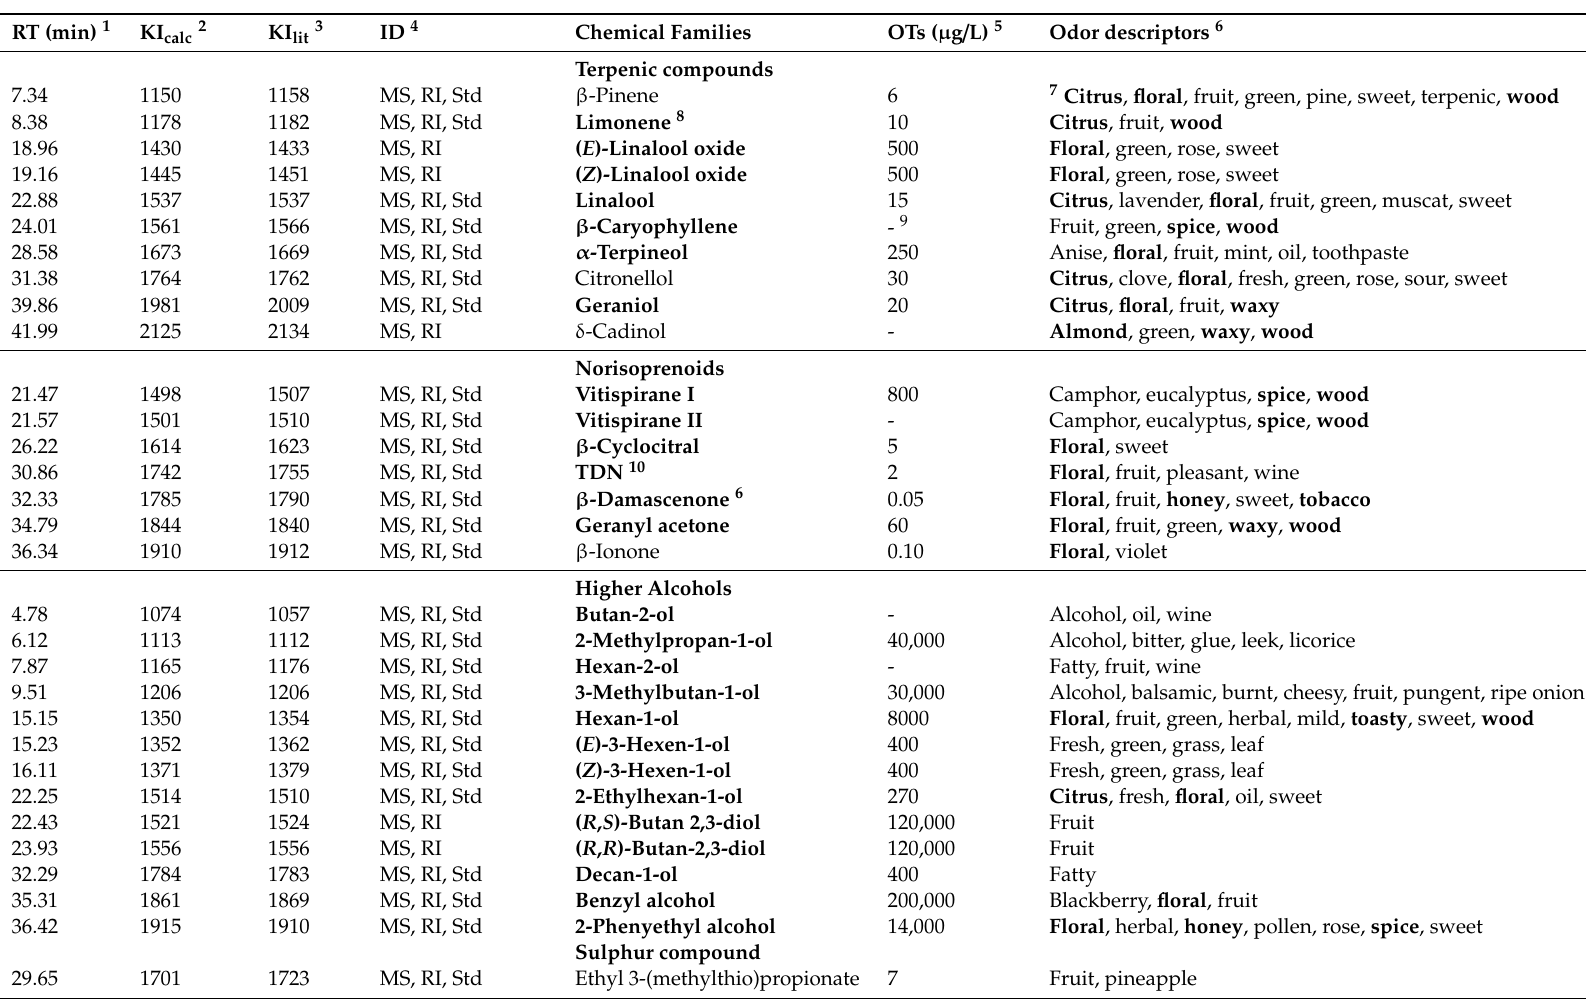
Table 1. Volatile organic compounds (VOCs) identified in Madeira wines by headspace solid-phase microextraction tandem with gas chromatography-mass spectrometry (HS–SPME / GC–qMS), and the corresponding odor thresholds and odor